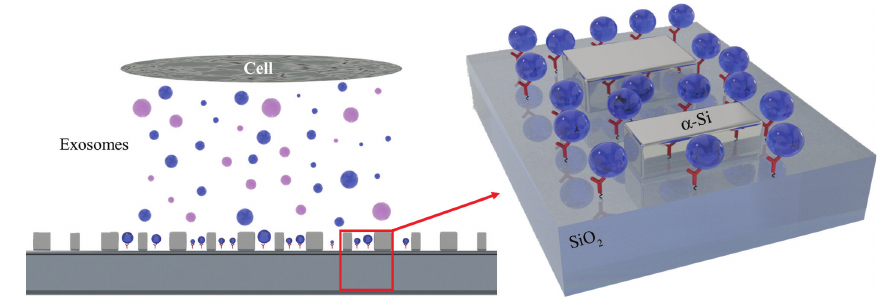
Figure 1: Design of the quasi-BIC supporting a high- Q